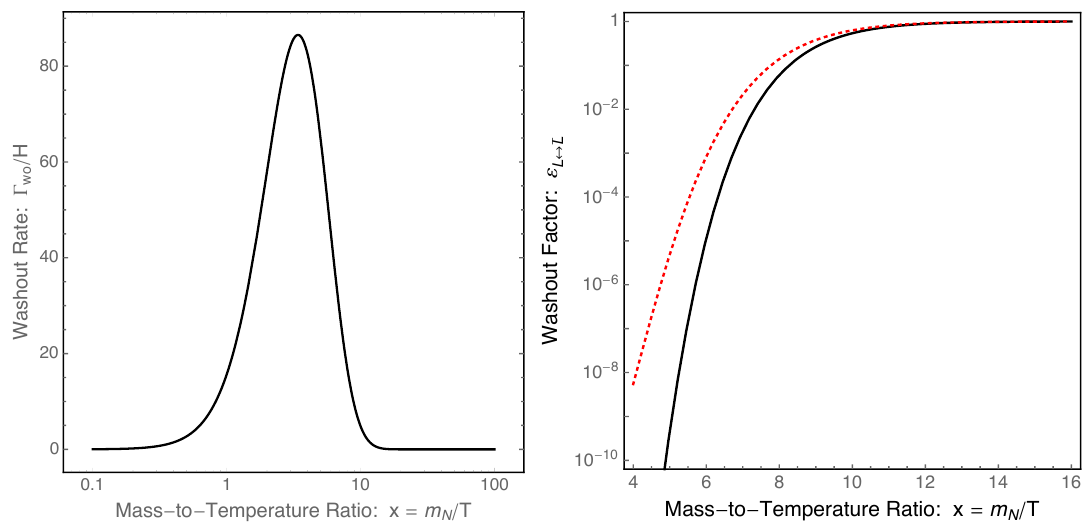
Figure 2 . The left panel shows the washout rate from eq. (2.19) normalized to the Hubble param- eter. The right panel shows the washout factor from eq. (2.18) in black and the approximation from eq. (2.20) in red (dashed). The washout of lepton-number is avoided provided that the Majorana neutrino mass m N is su(cid:14)ciently large inside of the